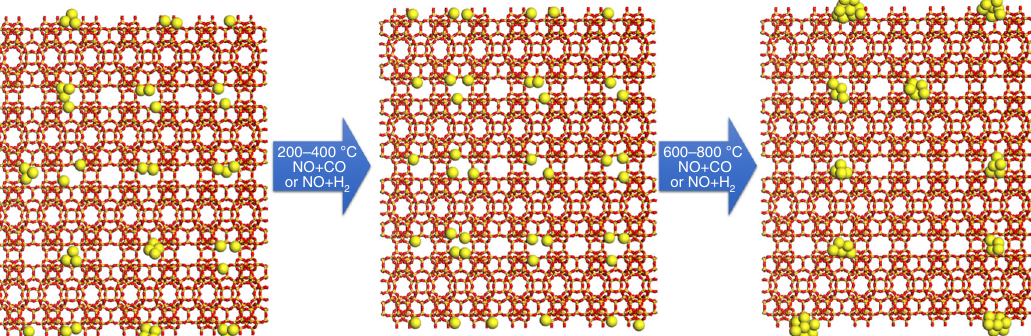
Fig. 7 Structural evolution of Pt species under CO + NO and NO + H 2 conditions. At 200 – 400 °C, Pt clusters will disintegrate and form highly dispersed Pt species. At higher temperature (600 – 800 °C), highly dispersed Pt species agglomerate into Pt clusters or even small Pt nanoparticles (1 – 2 nm). Due to the protection effect from MCM-22 framework, Pt clusters and small nanoparticles (1 – 2 nm) can be stabilized at such high